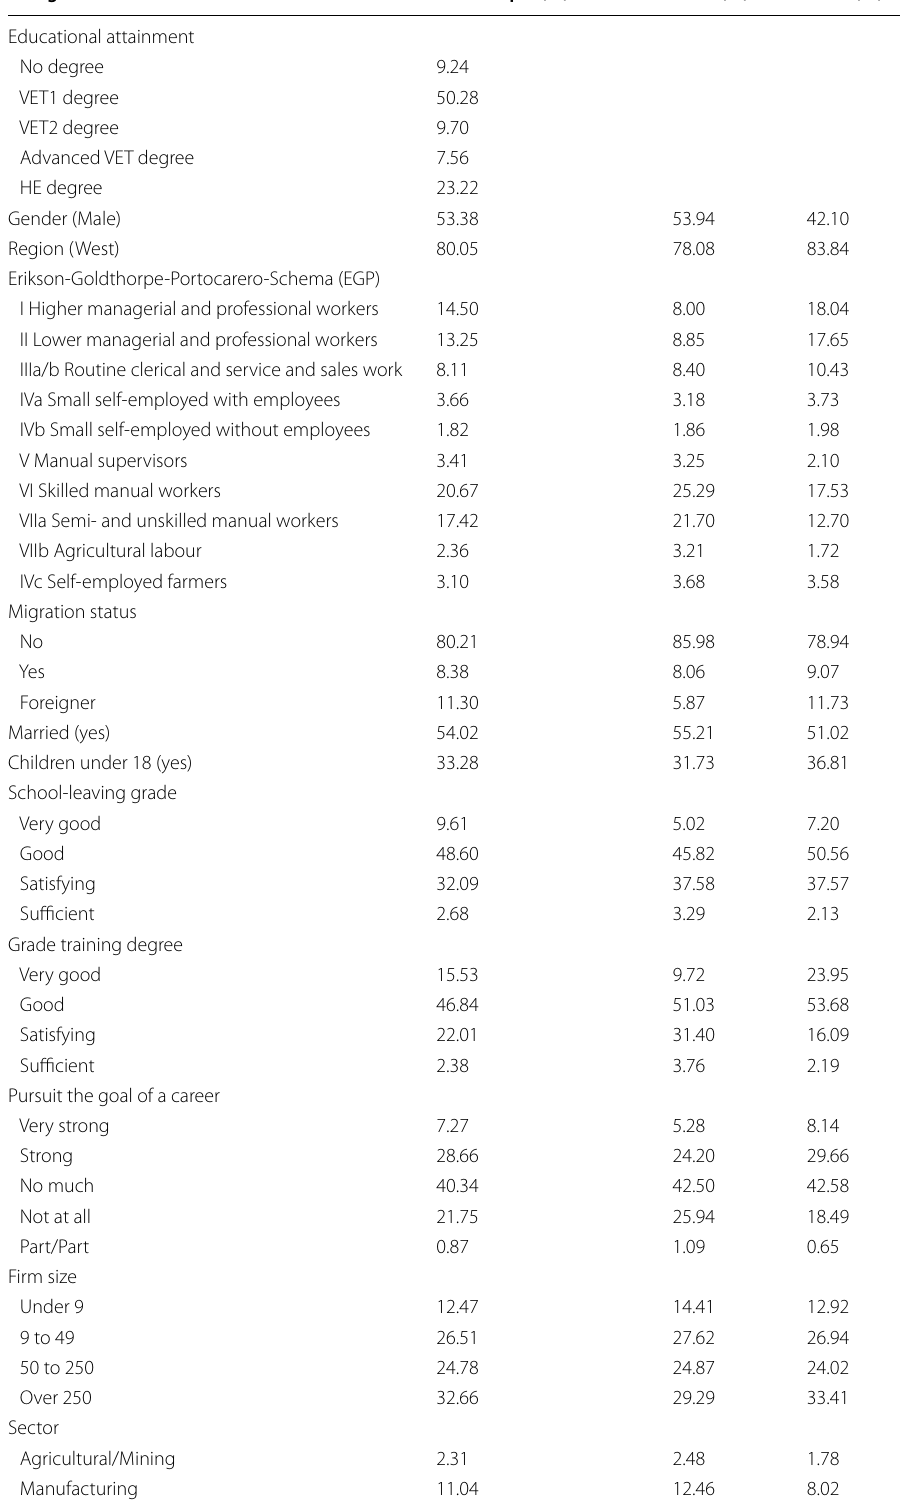
Table 1 Key variables of the data